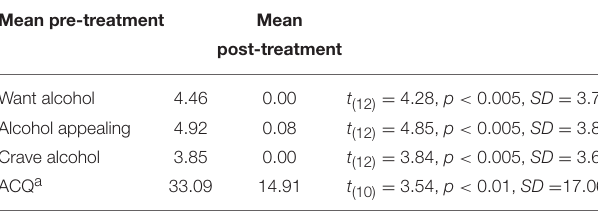
TABLE 1 | Patients’ ratings/responses on a subjective graphic rating scale questionnaire (three questions), before and after treatment. Mean pre-treatment